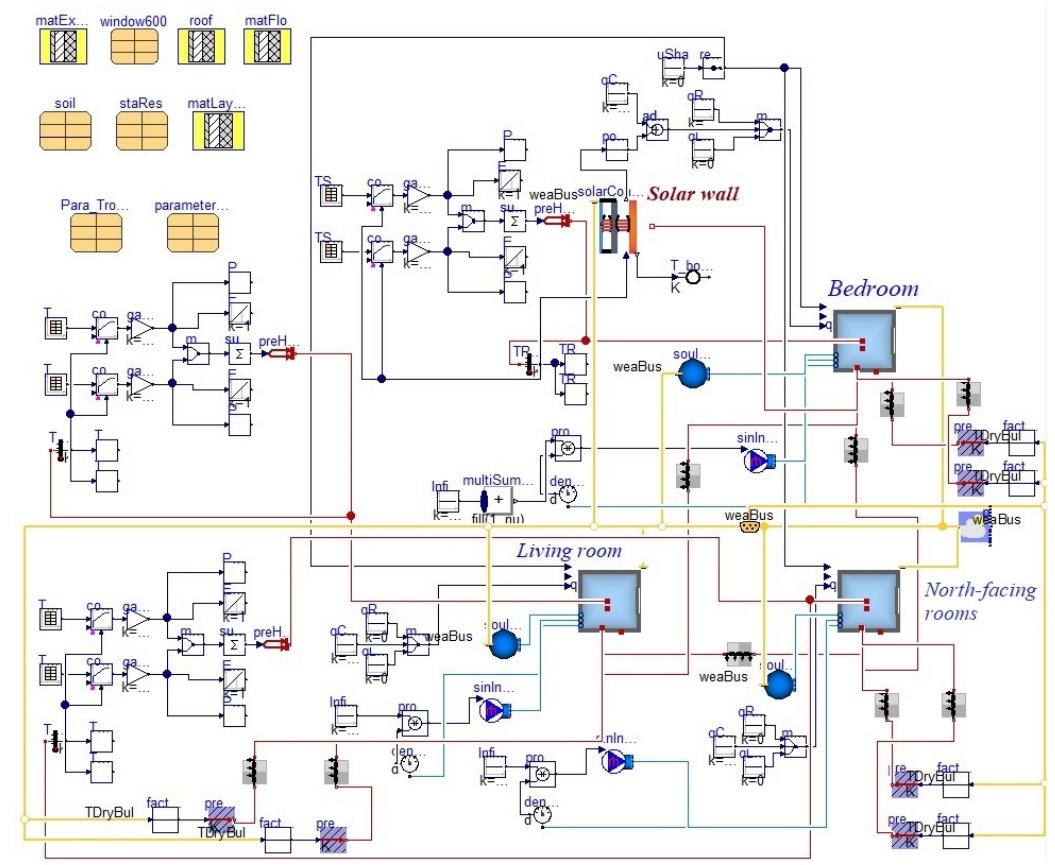
Figure 2. Modeled house using the Dymola Building Library.